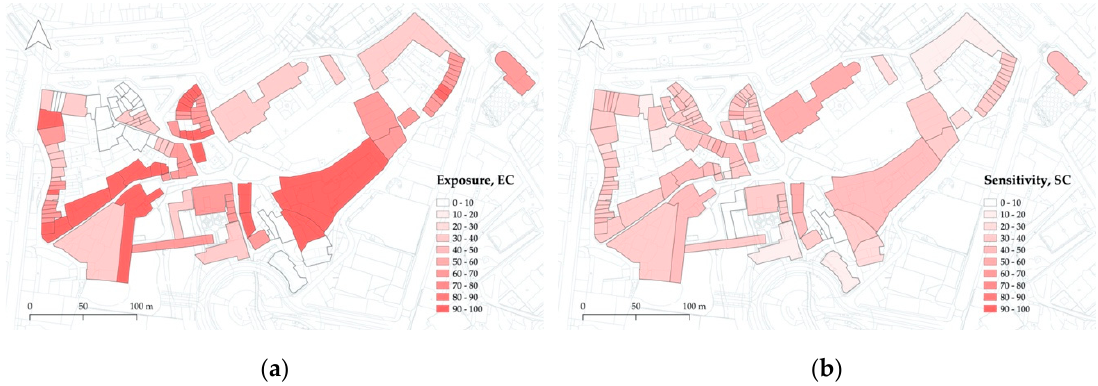
Figure 8. Spatial distribution of the exposure ( a ) and the sensitivity ( b ) indicators.